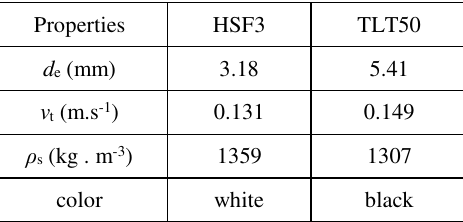
Table 1. Properties of sediments .